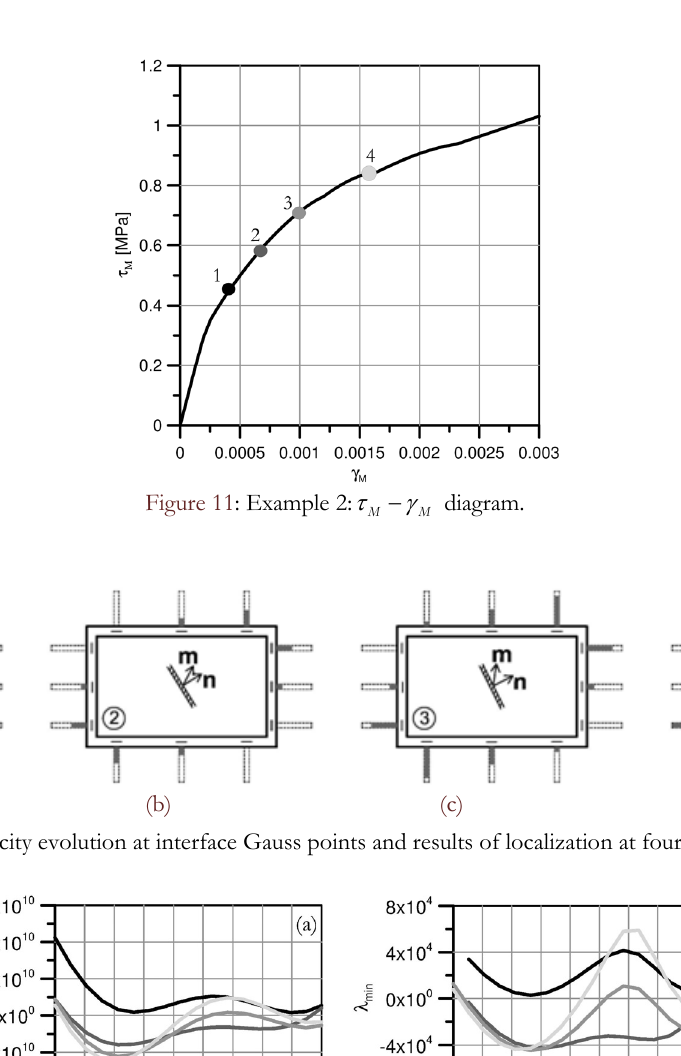
Figure 13: Example 2: determinant of localization matrix (a) and minimum eigenvalue (b) for different configurations of n vector. Colours of line refer to the stages indicated in Fig.